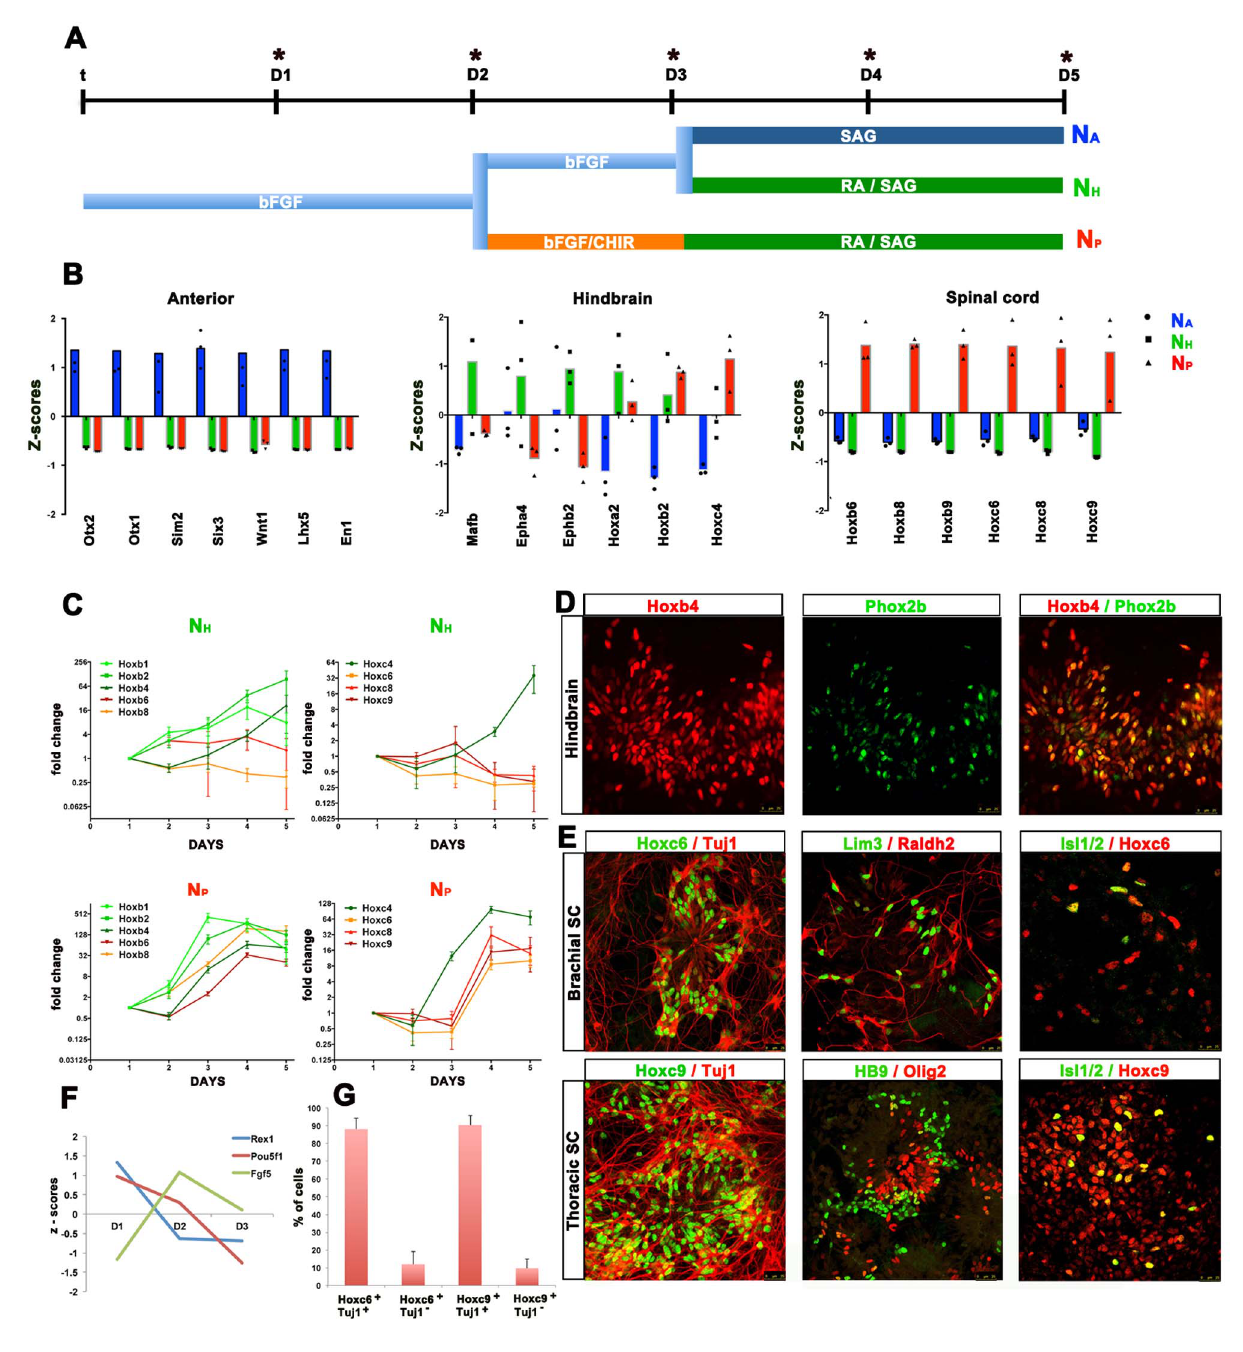
Figure 1. Generation of neural cells with specific AP identities from ESCs. (A) Schematic representation of differentiation conditions used for the generation of NPCs with specific Anterior (N A ), Hindbrain (N H ) and Spinal cord (N P ) identities. (B) Relative expression levels of the indicated genes from N A , N H and N P cells at day 5 (D5) of differentiation indicate that N A , N H and N P cells express distinct sets of genes. The standard scores (z- scores) of the indicated genes from mRNA-seq analysis reveals that N A cells express high levels of forebrain markers including Otx1 and Otx2 ; N H cells express genes characteristic of hindbrain including Mafb and Hoxa2 genes; N P cells express high levels of posterior 5 9 Hox genes including Hoxc8 and Hoxc9 . The individual Z-score for each replicate is indicated on the graph with circles, triangles and squares. (C) Time course of Hoxb and Hoxc cluster activation in cells cultured in N H and N P conditions showing fold change compared to D1. Posterior Hox genes are selectively activated only in the N P conditions and show temporal colinearity with the induction of anterior Hox genes prior to posterior Hox genes [74]. In N H cells Hoxb1 and Hoxb2 are induced prior to Hoxc4 . However, the more posterior Hox genes are not induced. By contrast, in N P conditions the 5 9 Hox genes Hoxc6 , Hoxc8 and Hoxc9 are induced at D4 and their expression is maintained at day 5. (Note log 2 scale). (D) Immunohistochemistry indicates that N H cells analysed at D8 differentiate into MNs of hindbrain identity coexpressing Hoxb4 and Phox2b. (E) N P cells exposed to SAG generate spinal neurons coexpressing Hoxc6 and Hoxc9 with b-tubulin (Tuj1). These were not detected in N H conditions. Coexpression of Hoxc6 and Hoxc9 with Islet1 indicates the generation of spinal MNs of forelimb and thoracic identity, respectively. These MNs also expressed Lim3/Raldh2 and HB9. (F) Graph showing the